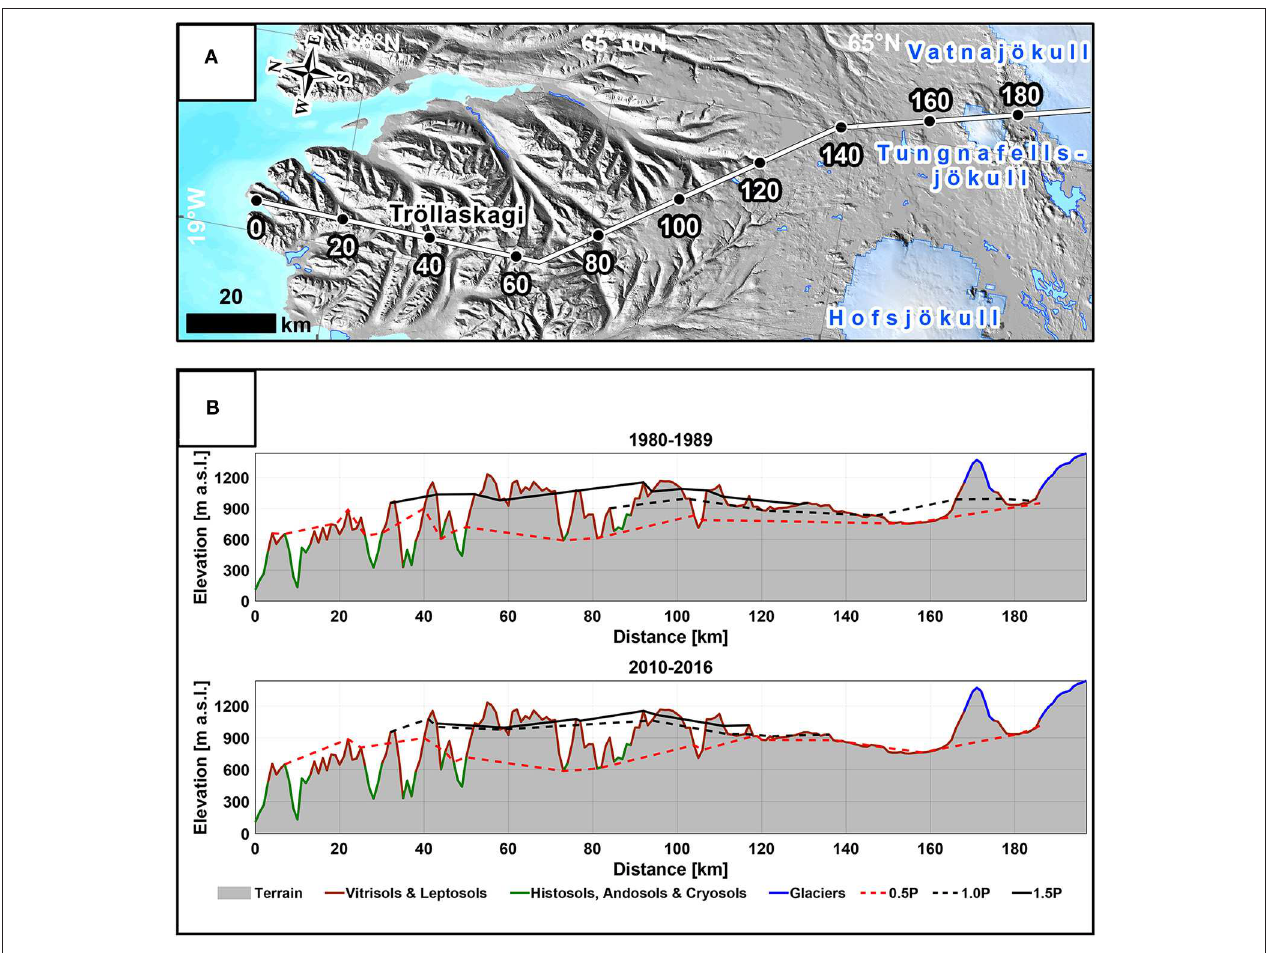
FIGURE 11 | (A) Transect from the northern part of Tröllaskagi to the north of Vatnajökull, similar to the transect in Etzelmüller et al. (2007). Numbers indicate distance along the transect in km. Map data from NLSI. (B) Lower limits of permafrost along the transect shown in A for the three precipitation scenarios: 0.5P-50% precipitation, 1.0P-100% precipitation, 1.5P-150% precipitation, in the periods 1980–1989 and